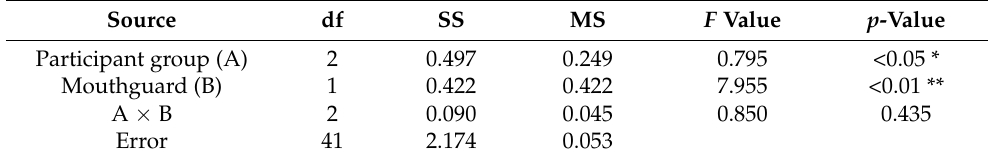
Table 2. Results of COP-LR displacement by a split-plot design analysis. Source